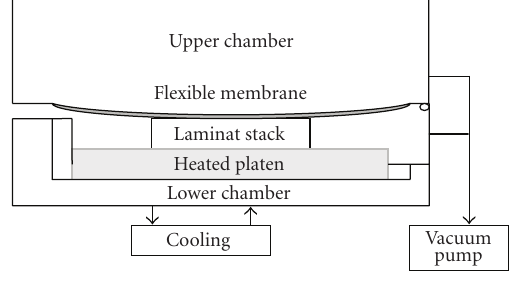
Figure 1: Schematic of the laminator.